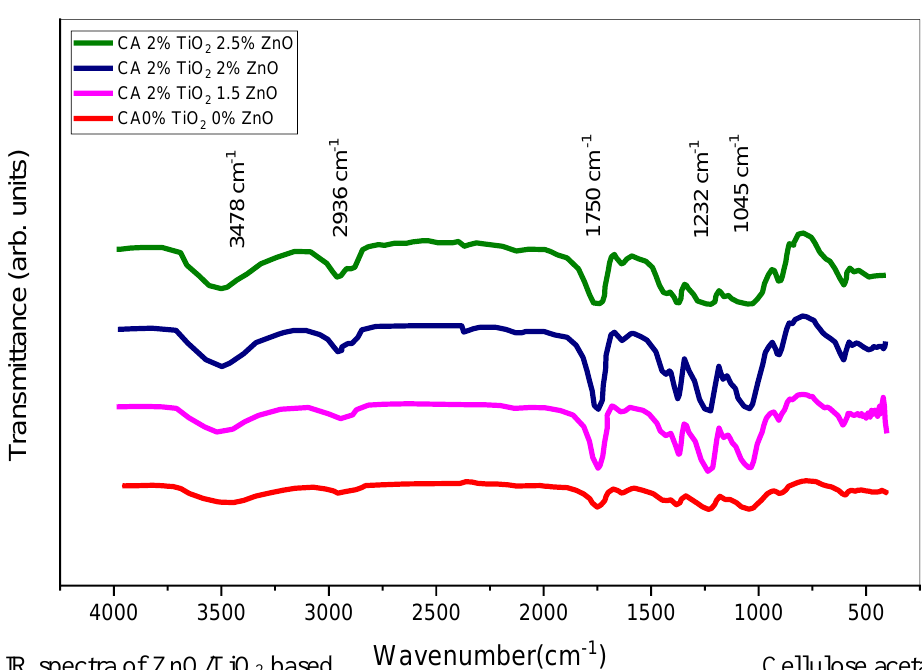
Figure 6: FTIR spectra of ZnO/TiO 2 based Cellulose